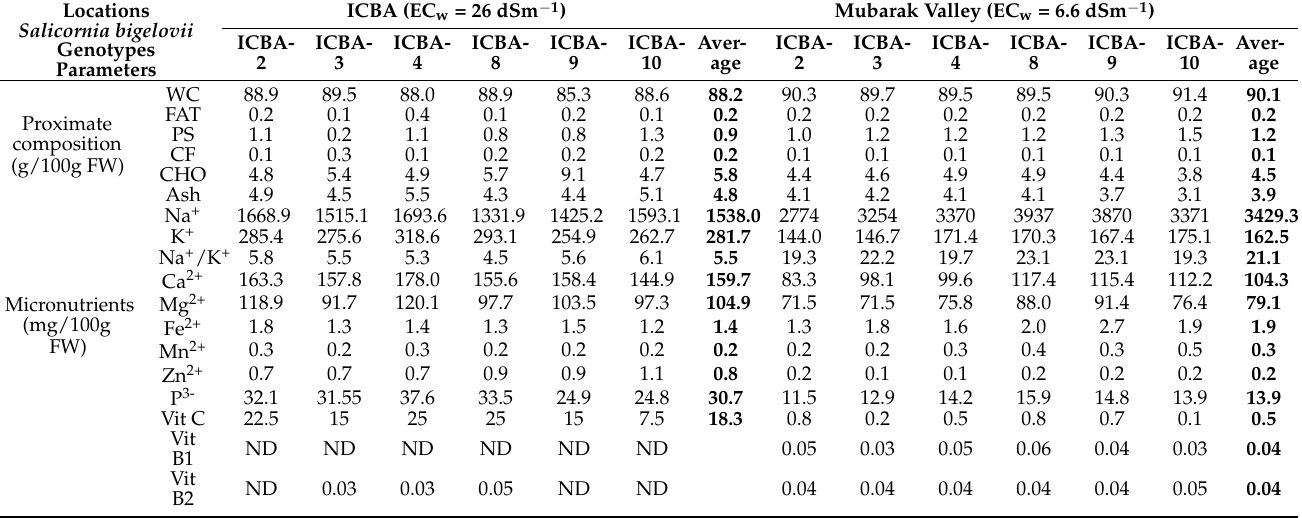
Table A1. Proximate composition (g/100g) and micronutrients (mg/100g) analyzed for shoots of six Salicornia bigelovii genotypes collected at three and a half months after sowing at ICBA’s experimental station and Mubarak Valley. The values are calculated on fresh weight (FW) basis. The average value per parameter from all genotypes was calculated (in bold) for each location.